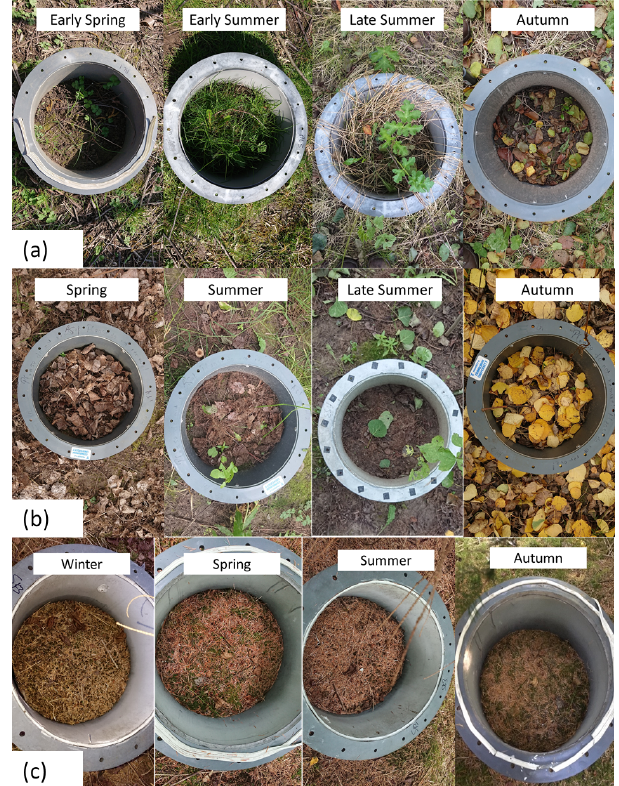
Figure 4. Changes in the presence of leaf litter, herbaceous plants and grasses inside the forest floor chambers of (a) Italian alder (b) hybrid aspen and (c) Sitka spruce SRF plots at East Grange, Fife, during 2019.